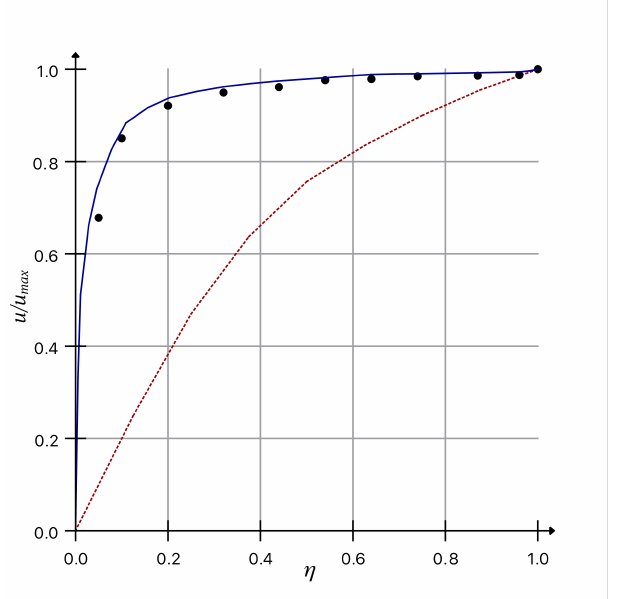
Figure 1. Non-dimensional velocity profile of a turbulent flow in comparison with laminar Poiseuille profile (dash line) and experimental results by L.S. Artjushkov [11] (shown as